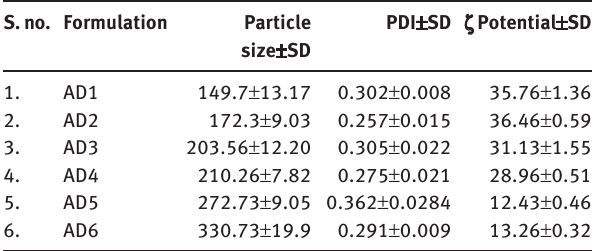
Table 2: Particle size, PDI, and ζ potential of different formulations.